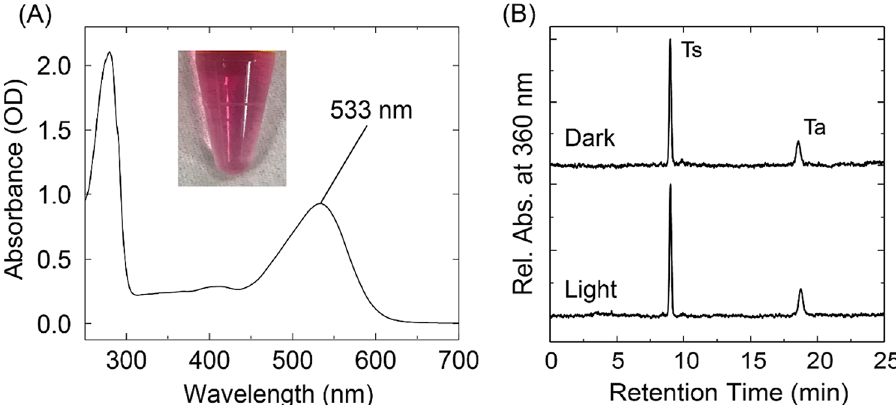
Figure 4. Absorption spectrum and retinal configuration of Om R2 expressed in E. coli cells . ( A ) Absorption spectrum of Om R2 purified from E. coli cells in Buffer A containing 50 mM Tris–HCl (pH 7.0), 1 M NaCl and 0.05% (w/v) DDM. The inset photograph represents the color of purified Om R2. ( B ) HPLC patterns of Om R2 in dark- and light-adapted states (upper and lower traces, respectively). Ts and Ta represent all- trans -15- syn and all- trans -15- anti retinal oximes, respectively.